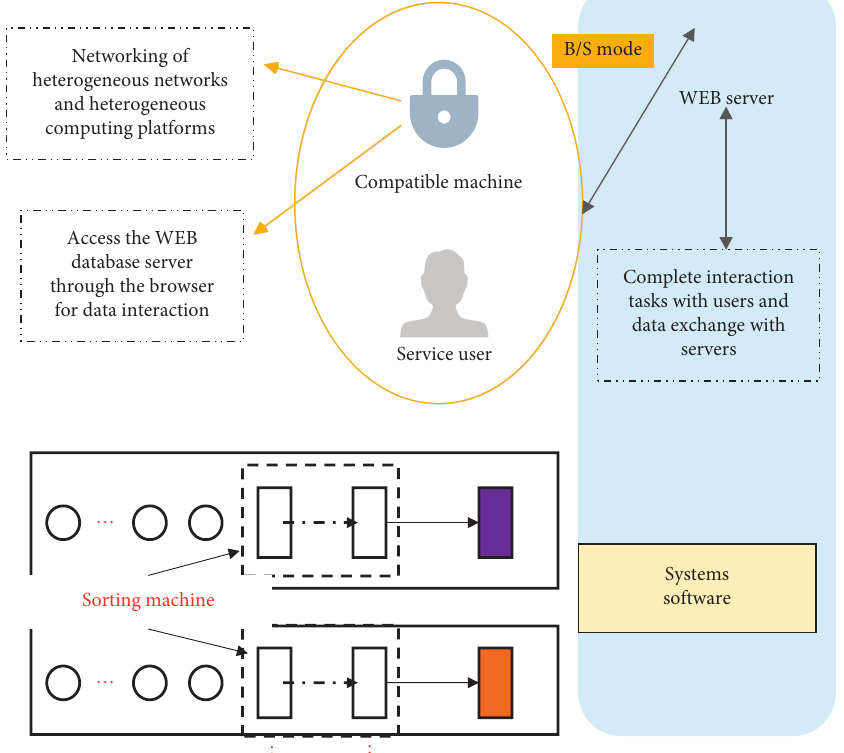
Figure 2: Latent variable generation model process